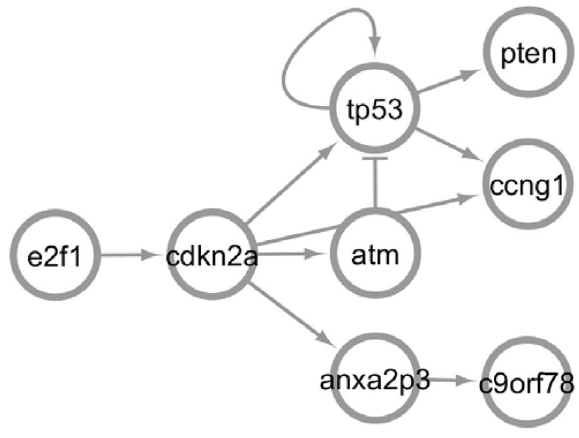
Figure 3. Example network created from semantic predica- tions, edited for simplicity. Arrows indicate stimulation; bars indicate inhibition; loops indicate self-stimulation or self-inhibition. Interactions are directed, so an interaction from atm to tp53 is distinct from one from tp53 to atm. A single interaction can represent a single or multiple